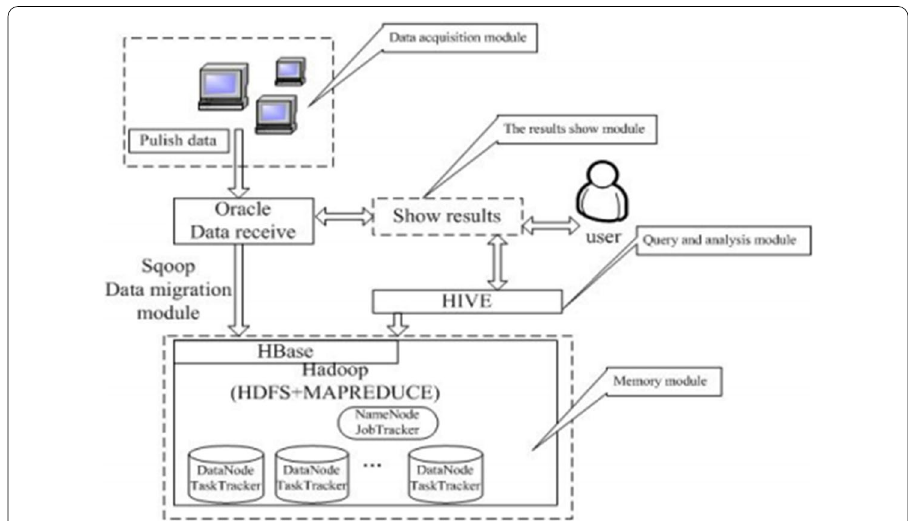
Fig. 12 The Private Cloud Storage Platform